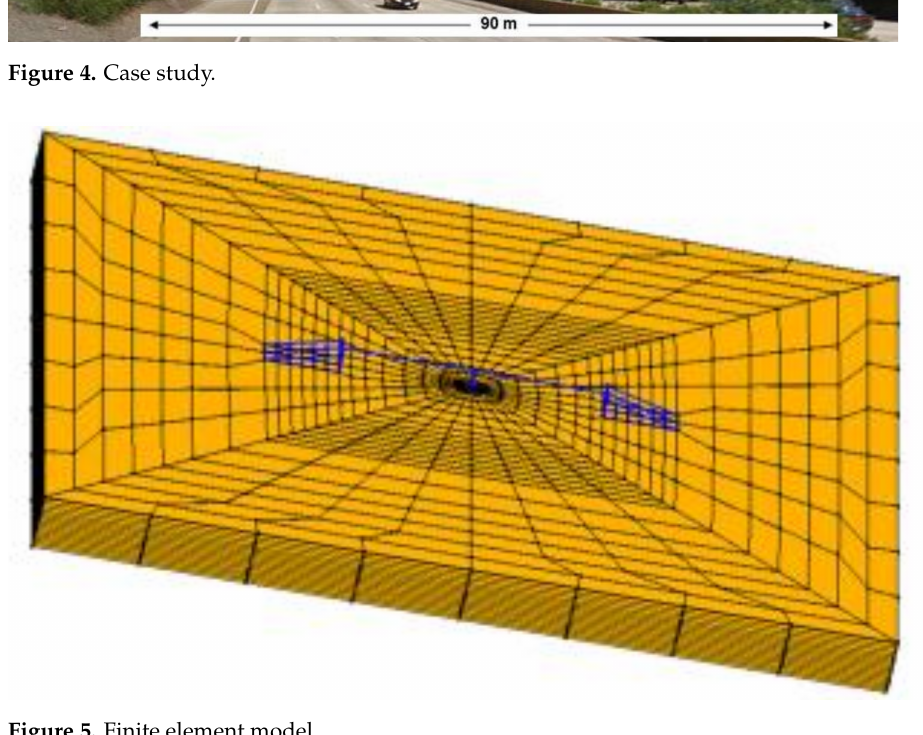
Figure 5. Finite element model.